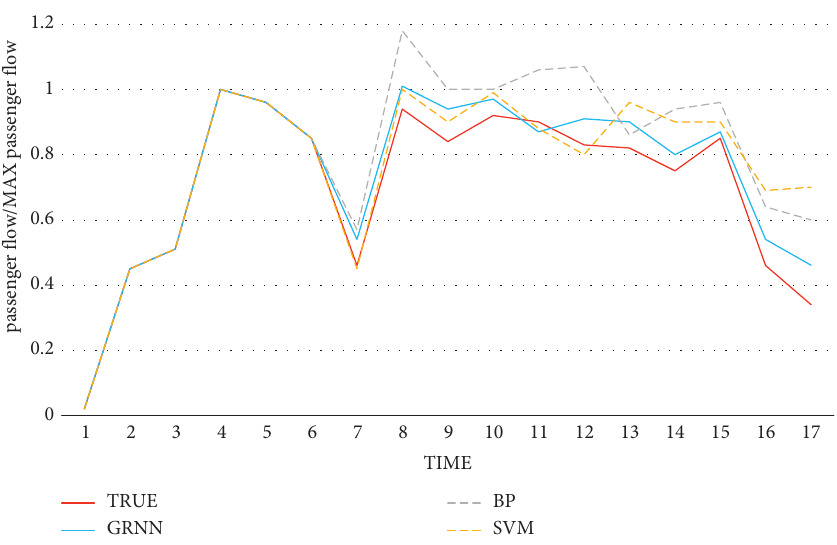
Figure 8: Validation comparison of different prediction